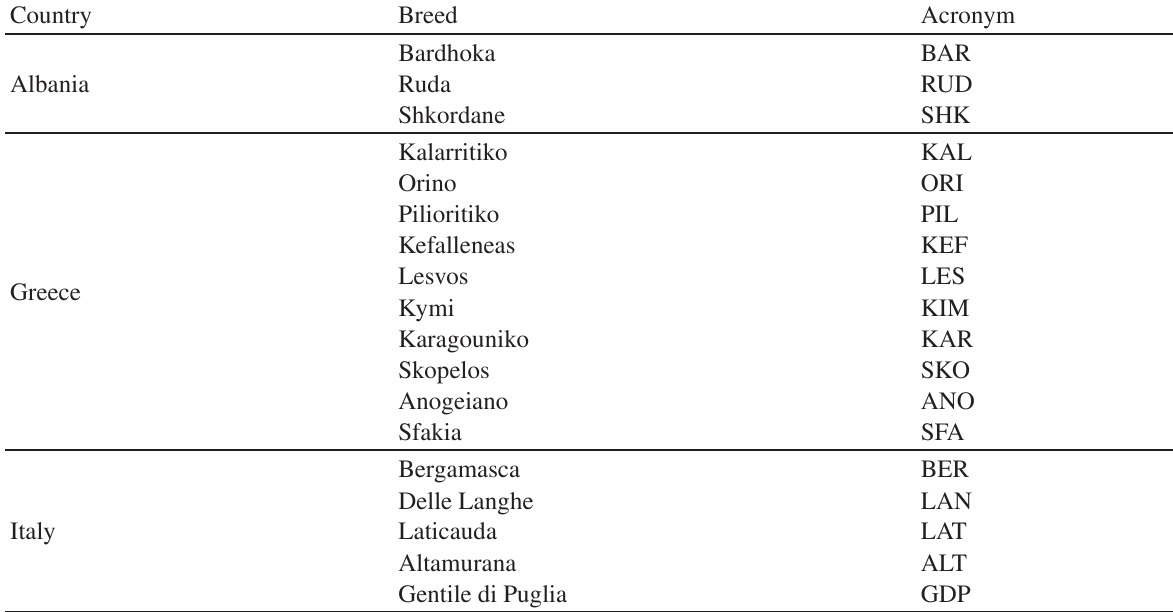
TABLE 1: Country of origin, breeds, and acronyms used in